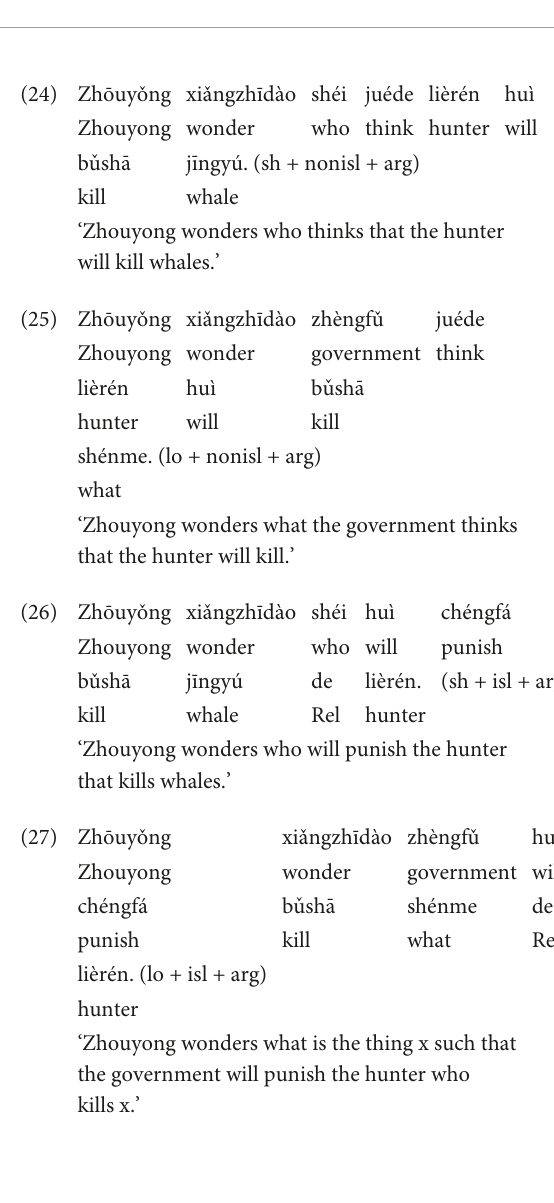
FIGURE2 Mean acceptability rating